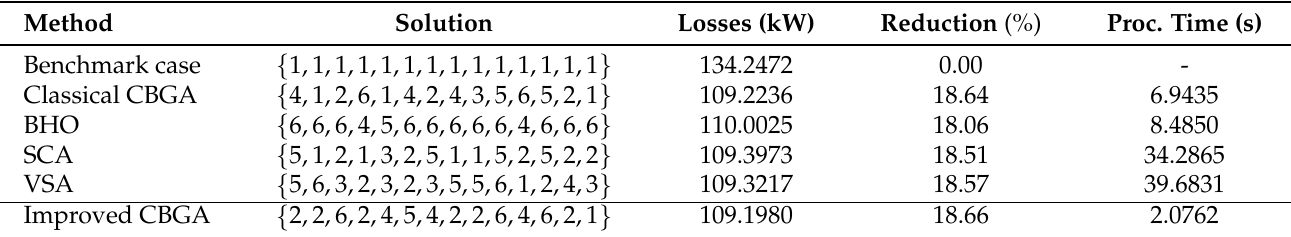
Table 6. Power loss performance after applying the phase-balancing approach in three-phase networks, considering all loads with the Y